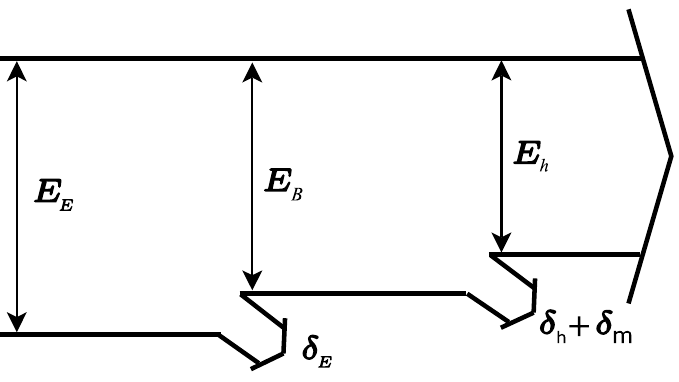
Figure 1. Energy block diagram.